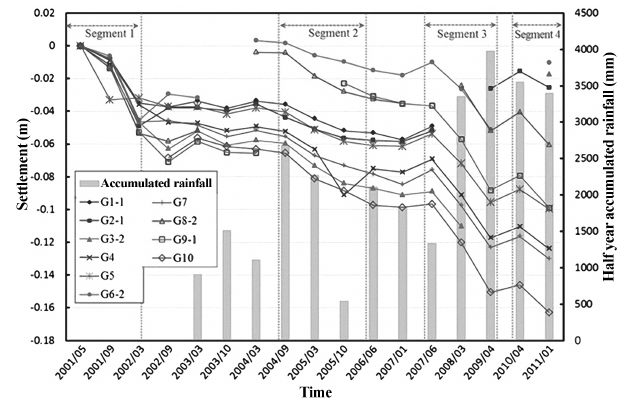
Figure 10. Curves of settlement and rainfall per half year for the Hui-Tsui building